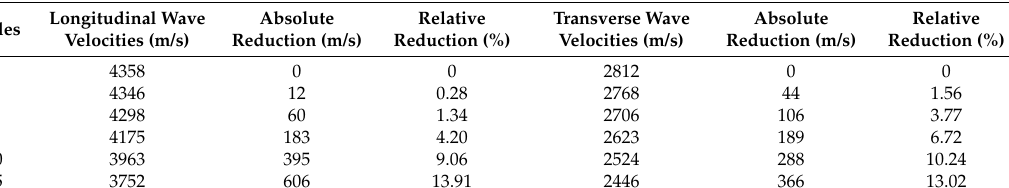
Table 3. Experimental results of acoustic wave velocity tests.